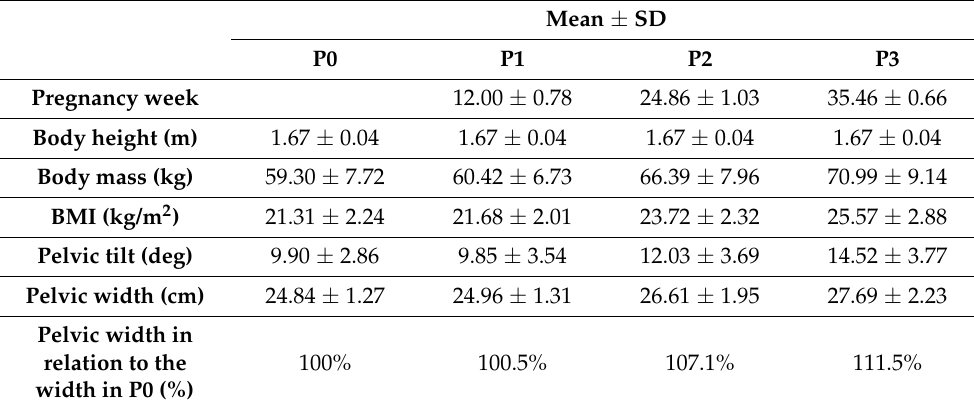
Table 1. Anthropometric data of women: P0—before pregnancy, P1—in the first trimester, P2—in the second trimester, P3—in the third trimester [30,31]. Mean ± SD P0 P1 P2 P3 Pregnancy week 12.00 ± 0.78 24.86 ± 1.03 35.46 ± 0.66 Body height (m) 1.67 ± 0.04 1.67 ± 0.04 1.67 ± 0.04 1.67 ± 0.04 Body mass (kg) 59.30 ± 7.72 60.42 ± 6.73 66.39 ± 7.96 70.99 ± 9.14 BMI (kg/m 2